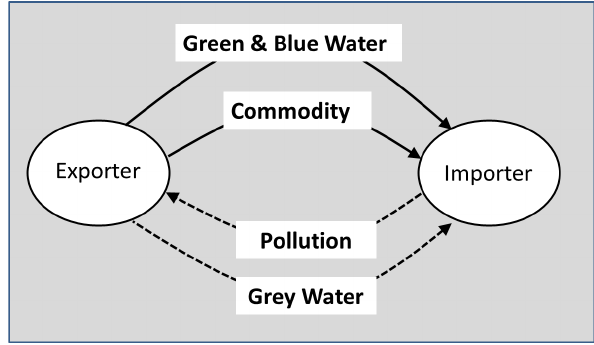
Fig. 1. Green and blue water are virtual water sourced from soil and surface water, respectively. Virtual water goes from exporters to im- porters in the form of commodities, but the pollution due to produc- tion stays in the exporting country. Hence exporters accumulate the pollution of importers and importers externalize their pollution at the expense of the exporters. The dashed arrows for pollution and grey water represent that these are theoretical flows. While not ac- tually being transferred, the avoidance or burden of pollution, and the accumulation or deficit of grey water, are phenomena with real